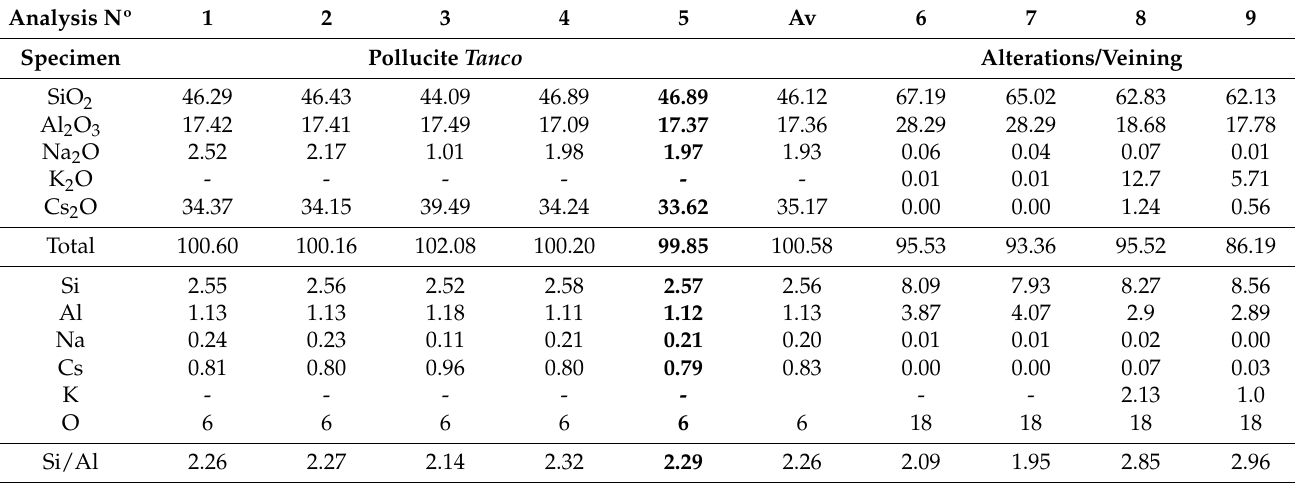
Table 1. Chemical compositions by EMPA of specimen Tanco